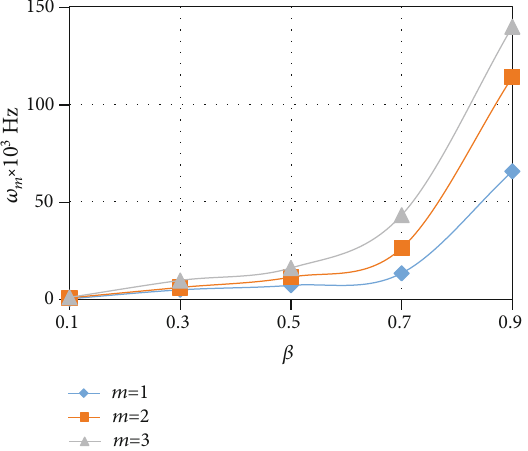
Figure 8: Variation of angular frequency and radius ratio of 3- layered annular circular plates.